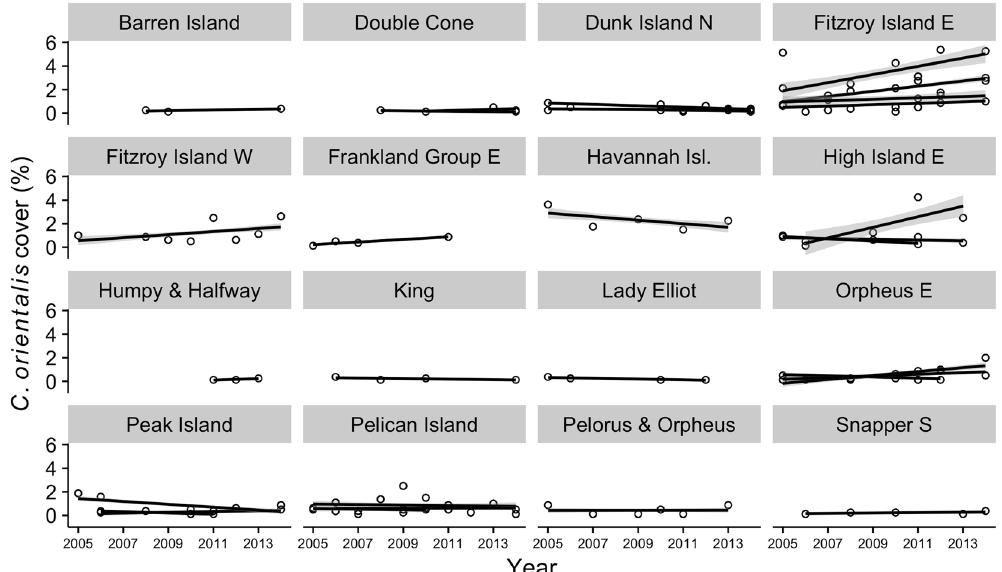
Figure 2. Trends in Cliona orientalis cover from 16 locations between 2005 and 2014. C . orientalis was found at 1–4 of the sites at each location. Linear regressions were fit to each site. Lines indicate the linear fit for each site and gray shading represents the standard error of the